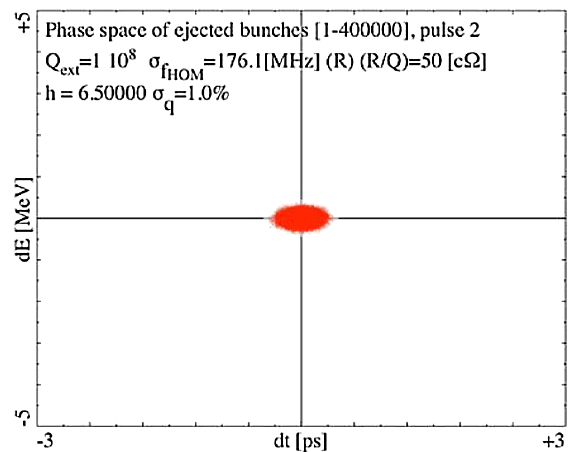
FIG. 34. (Color) Phase space at ejection (pulse 2) for 250 independent HOMs, one per cavity, f H scattered at random over a range of 352.2 MHz between h ¼ 6 and h ¼ 7 .